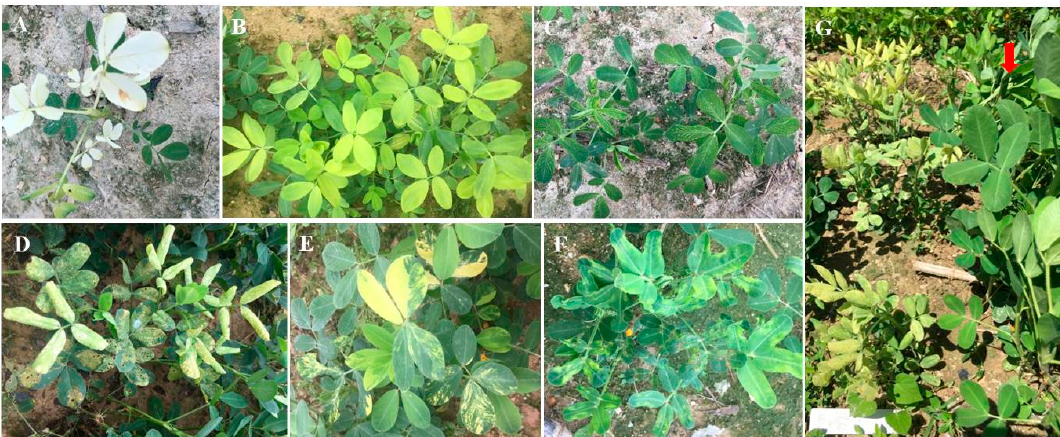
Figure 7. Mutants of leaf color of HY22 and YY45. ( A – E ) Mutants of yellow, pale green, veinal chlorine and mosaic leaves of HY22; ( F , G ) Mutants of mosaic and pale green leaves of YY45. Red arrow indicates the corresponding control.